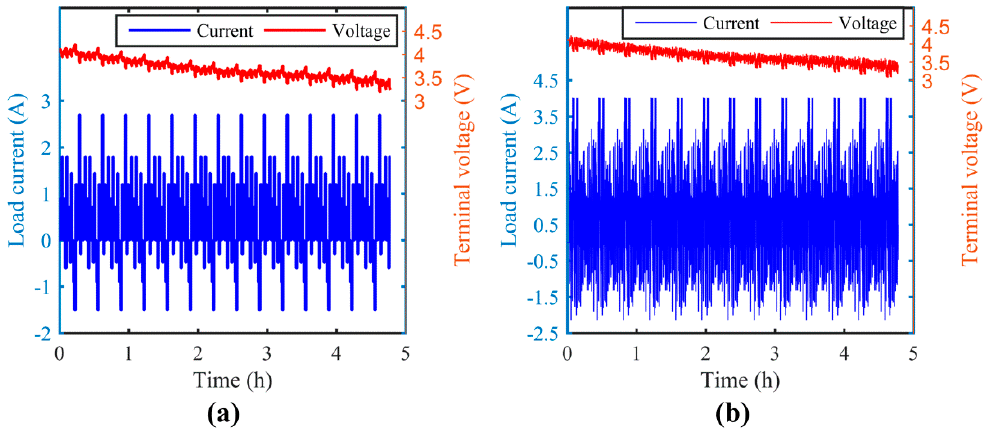
Figure 3. Load current and terminal voltage of the simulation study: ( a ) hybrid pulse test (HPT); ( b ) Federal Urban Dynamic Schedule (FUDS).